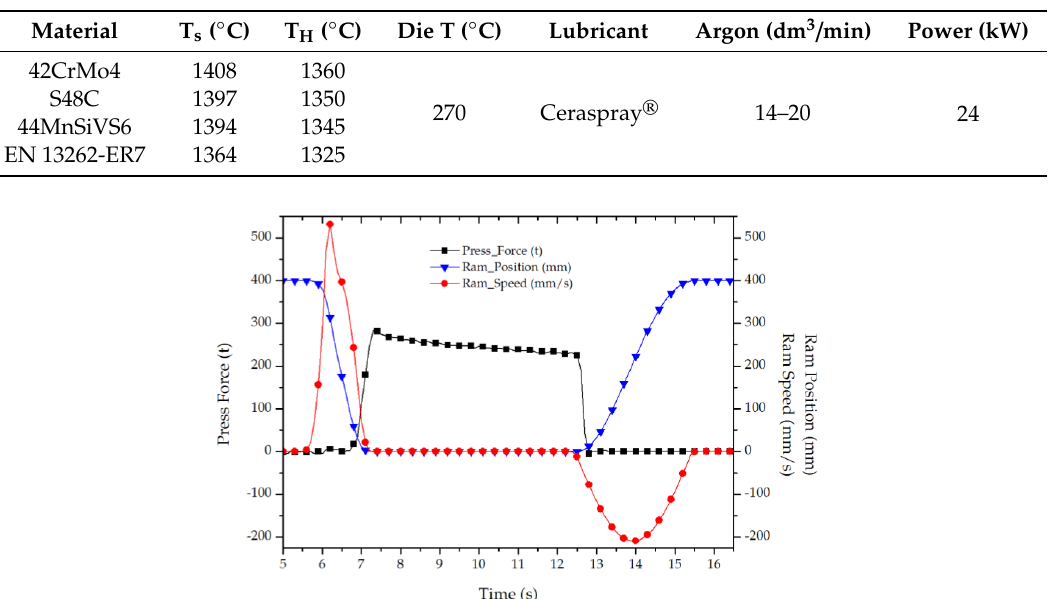
Table 3. Die temperature, lubricant, argon flow, solidus temperature (T S ), heating power, and temperature of the billet at the end of the heating cycle (T H ) for each tested steel.